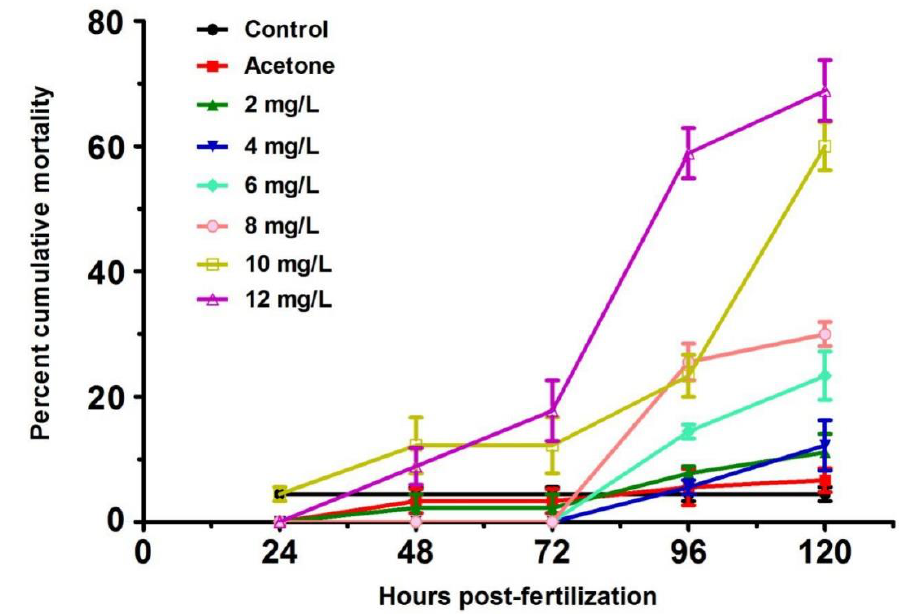
Figure 1. Cumulative mortality of zebrafish larvae exposed to 2,4-DNT-free (control) acetone-only (acetone) and 2, 4, 6, 8, 10, and 12 mg/L of 2,4-DNT.